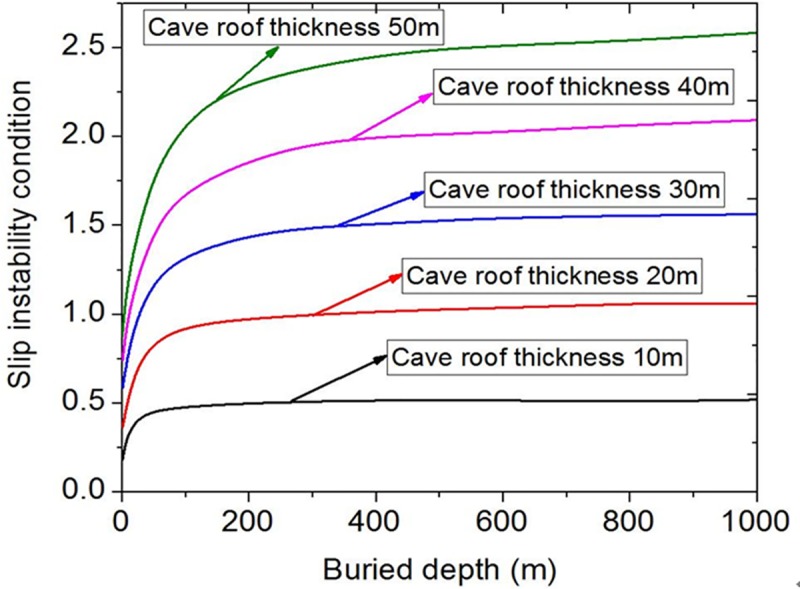
Influence curves of different cave roof thickness.